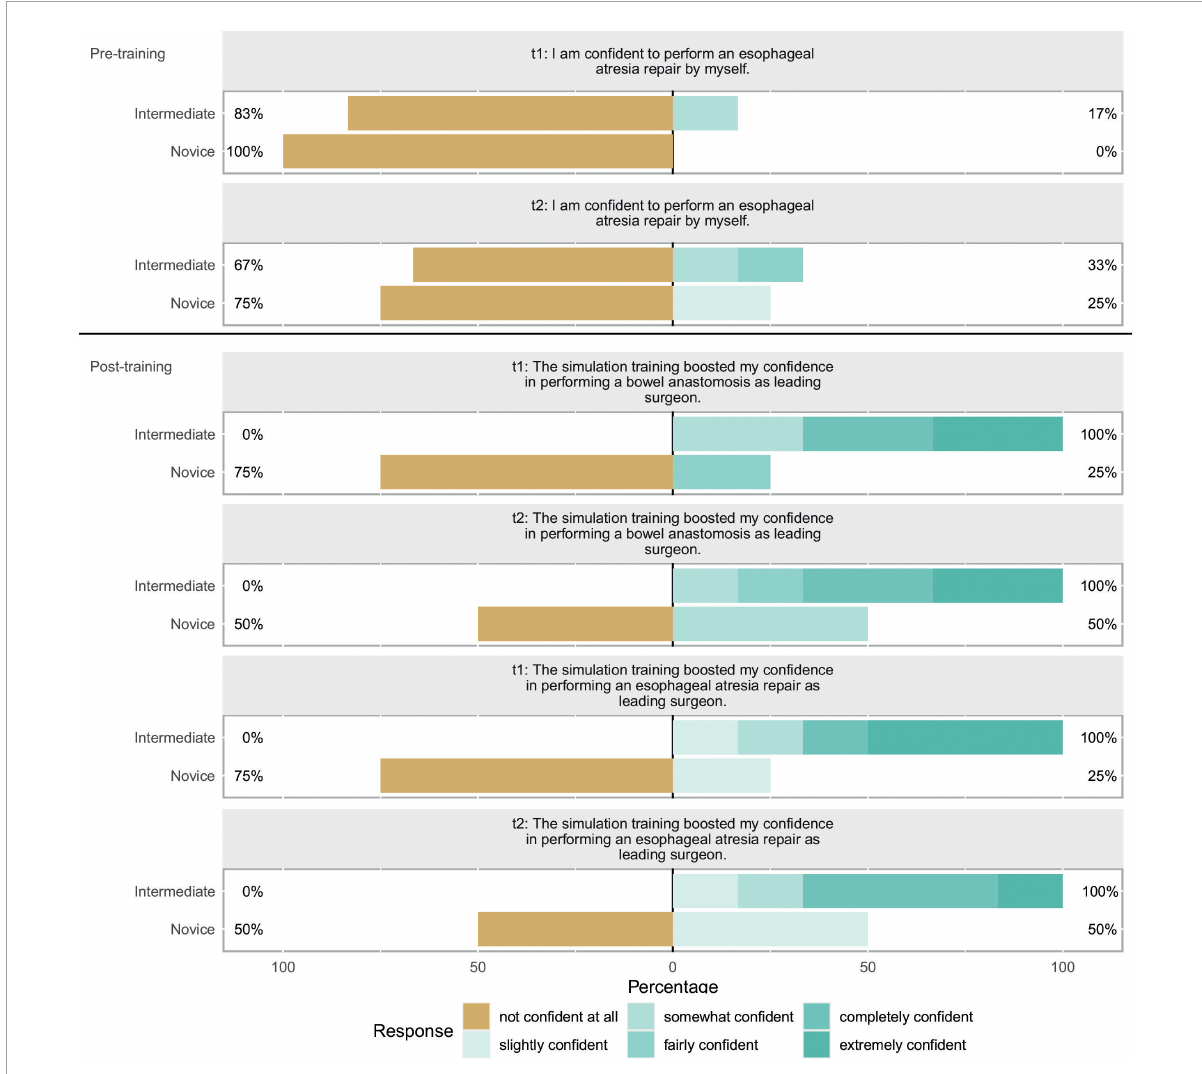
FIGURE3 Self-reported confidence evaluation: This Likert shows self-reported confidence items for t1 and t2. The scales show the respective fractions of participant answers to the questionnaire. Percentages on the left side show total amount of disagreement and percentages on the right side total amount of agreement with the respective item. In discordance to the other ten items, these items were scored differently with only one item having a distinctly negative connotation. The respective questions are featured above the bars. Bar color represents the given response according to the legend. A subgroup categorization was carried out for this plot. Participants were separated in “Intermediate” and “Novice” depending on their level of training. The cutoff was chosen so both groups were equally large. Q1 was asked before assembly of the model at both timepoints while Q2 and Q3 were both asked after assembly and usage of the